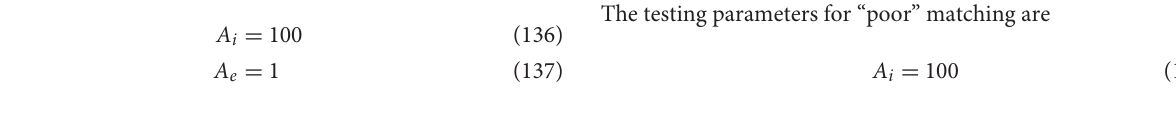
on the plasma behavior as this wave interacts with the